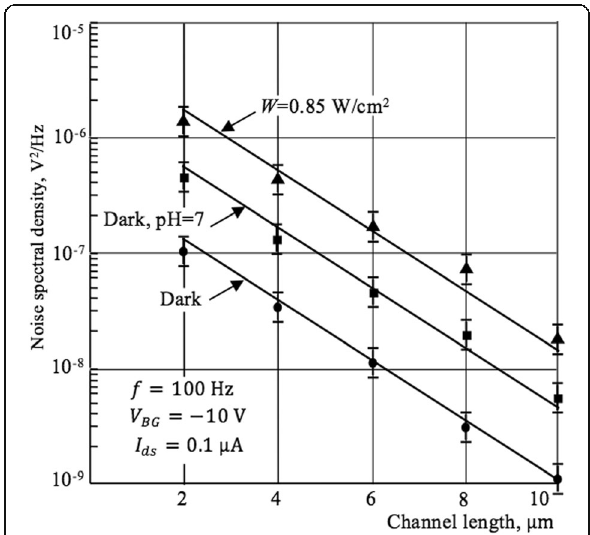
Fig. 11 Noise spectral density vs current channel length. Plot of